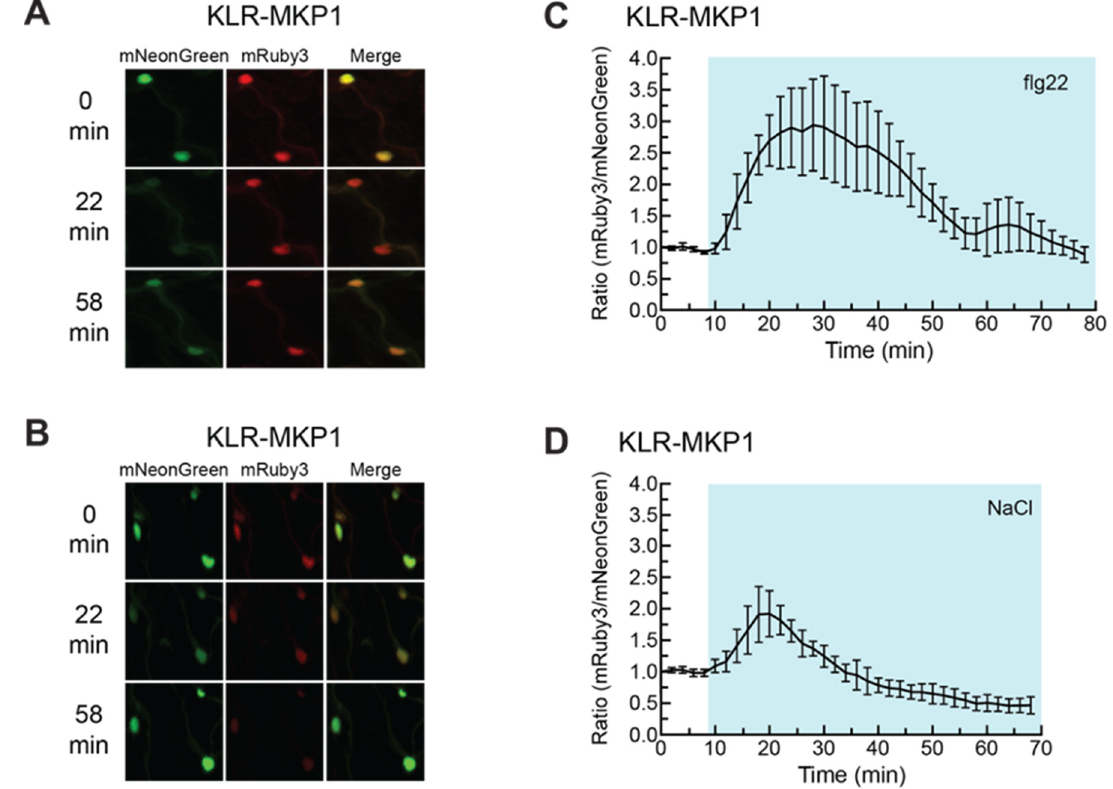
Figure 5. flg22 and NaCl cause a transient reduction in nuclear mNeonGreen fluorescence of KLR-MKP1. ( A , B ) Arabidopsis cotyledons expressing KLR-MKP1 were treated with 1 µ M of flg22 ( A ) or 150 mM NaCl ( B ) and were imaged every two min using confocal microscopy at 20 × optical magnification. The mNeonGreen, mRuby3, and merged channels for the 0 min, 22 min, and 58 min time points are shown for each experiment. mNeonGreen emission is shown in green. mRuby3 emission is shown in red. ( C , D ) Quantification of the nuclear fluorescent emission for the experiments shown in ( A , B ). Each data point represents the ratio of the average mNeonGreen and mRuby3 emission intensities within four regions of interest (ROIs) corresponding to cell nuclei. The data were normalized by dividing each value in the time-course by the 0 min value. The shaded background on each graph indicates when the sample was exposed to a given treatment. During the first 10 min of each experiment the samples were incubated in pure water. Error bars indicate standard deviation. Videos are available as Movies S5 and S6.